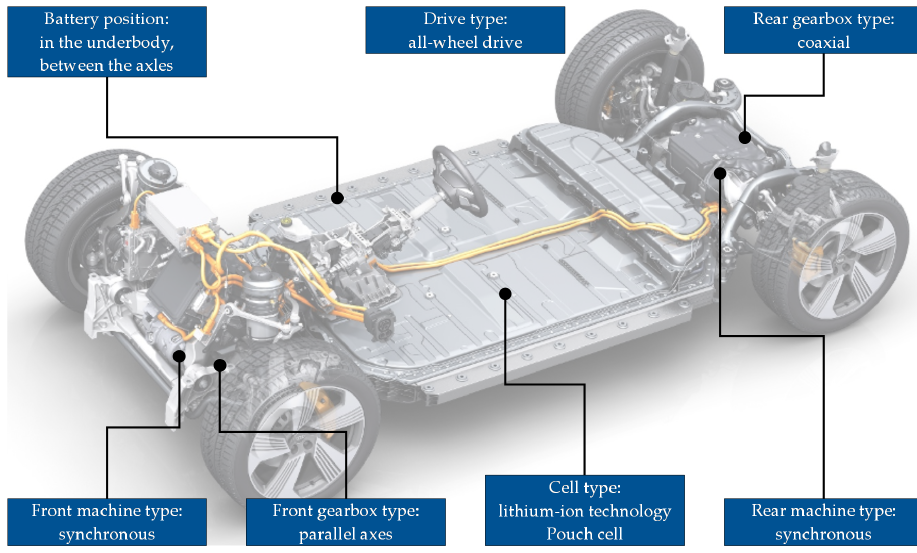
Figure 4. Overview of the design parameters for the powertrain topology, based on [70].